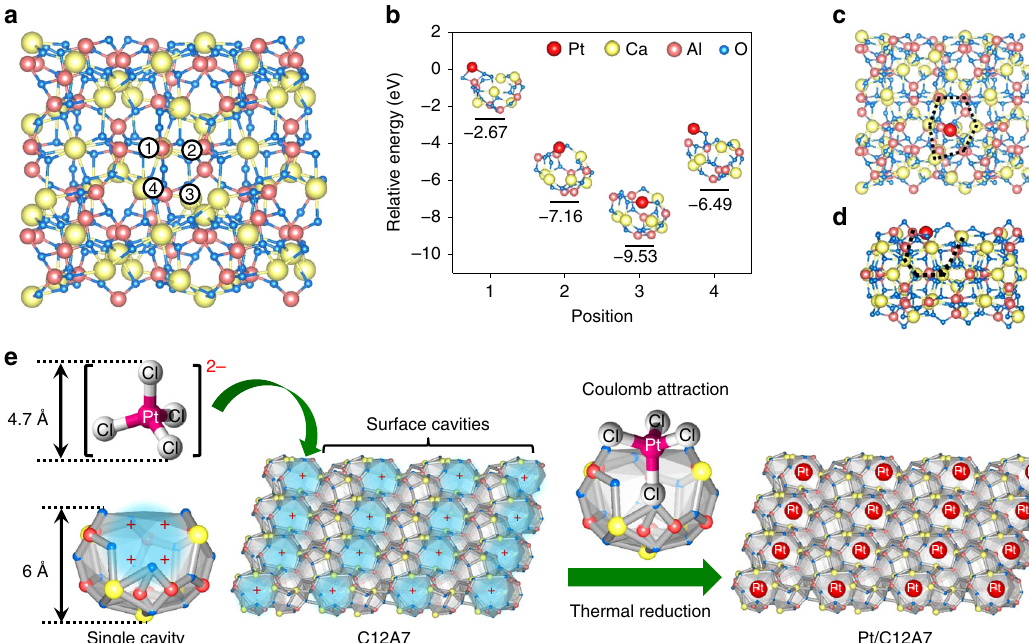
Fig. 1 Calculated adsorption models and schematic illustration of Pt/C12A7 synthesis. a Adsorption sites and b energetics of the adsorbed Pt single atoms on the (001) surface of C12A7 obtained from DFT calculation. The circles 1 – 4 in a indicate four energy favored adsorption sites nearby a typical cavity structure. Con fi gurations of the most stable anchored Pt single atom on the surface by top ( c ) and side ( d ) view, respectively. Black dotted lines in c , d indicate open mouths of surface cavities. e Interaction between negatively charged [PtCl 4 ] 2 − ions and positively charged surface cavities of C12A7 for effective stabilization of single Pt